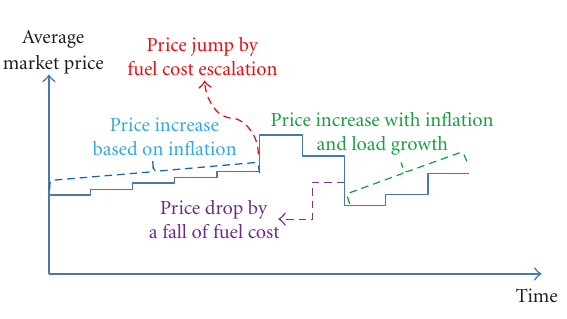
Figure 19: Long-term average price variation.